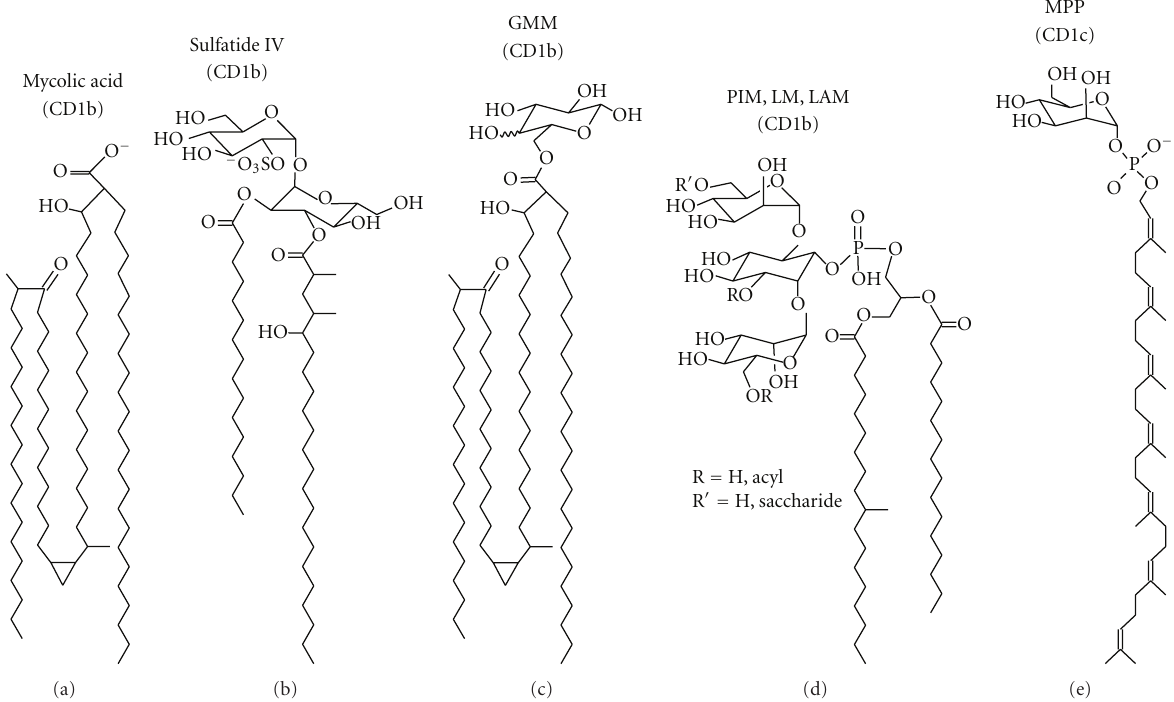
Figure 3: Nonpeptide T-cell antigens associated to the cell wall of Mycobacterium tuberculosis. The amphipathic nature of lipids is mandatory for antigen presentation. The variety of lipids associated to mycobacterial cell envelope include mycolic acids, diacylated sulfatide, glucose monomycolate (GMM), phosphatidyl inositol mannosides (PIM), lipoarabinomannan (LAM), and cell-wall biosynthetic precursors from the isoprenoid family, such as mannosyl phosphopolyprenol (MPP). Restriction to specific CD1 isoforms is